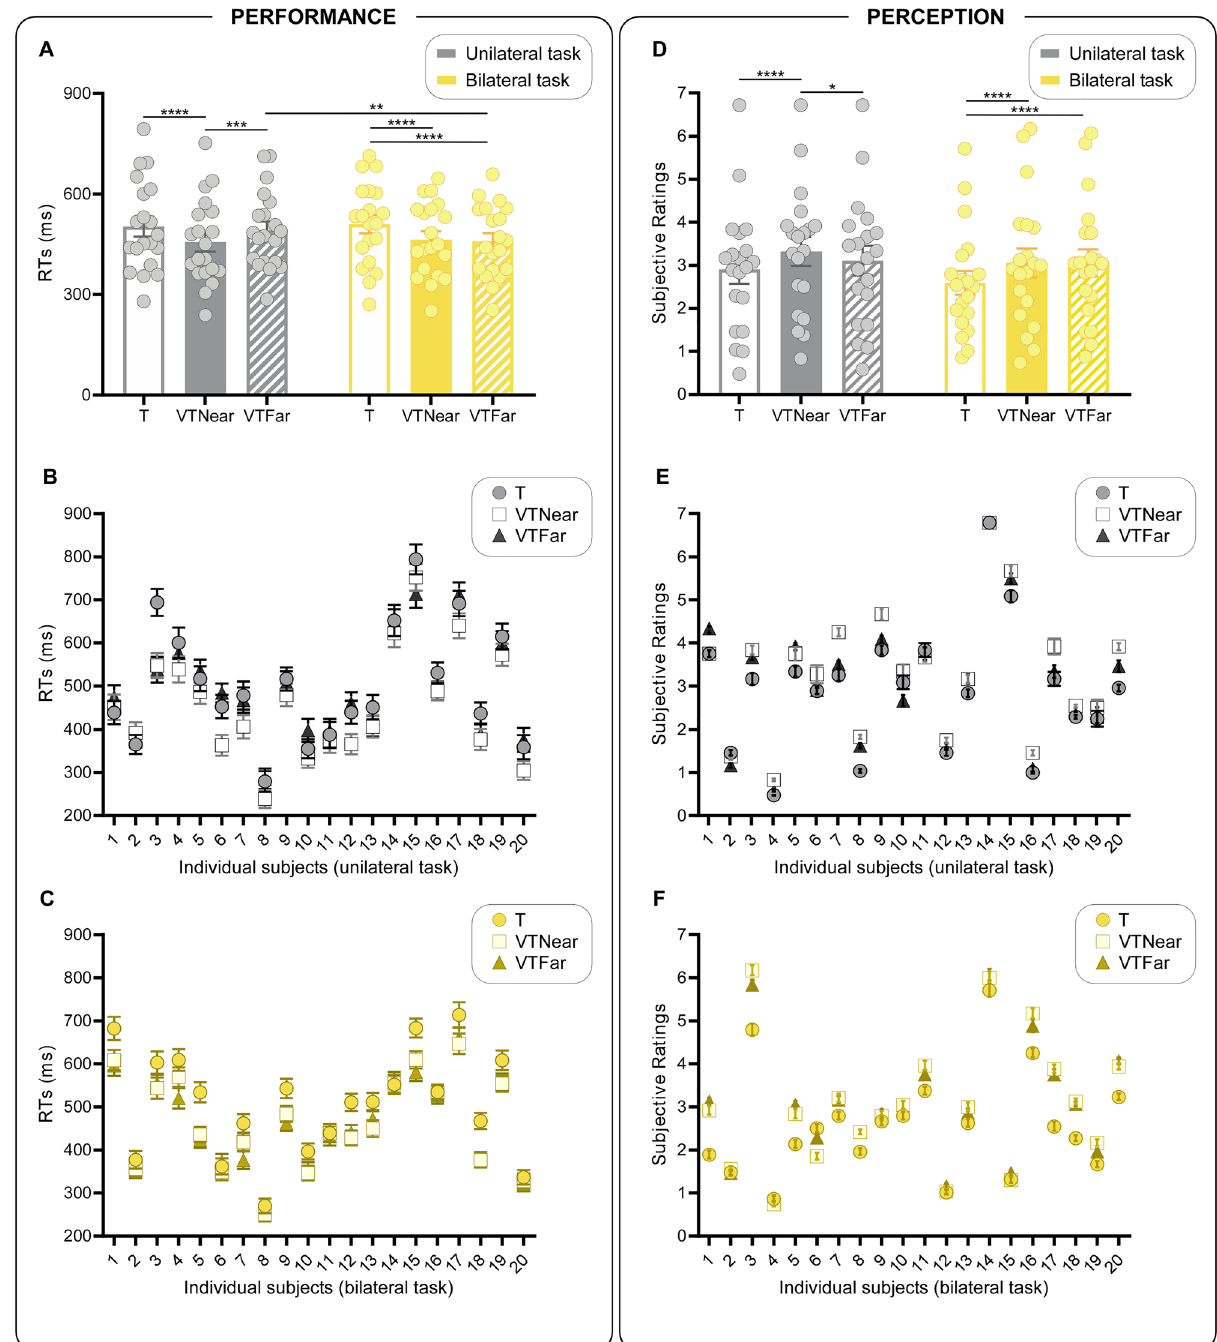
Figure 2. Performance and perception results. ( A,D) Represent the task × condition interactions. Bars represent the mean RTs ( A ) and the mean subjective ratings ( D ) in T (empty), VTNear (solid), and VTFar (striped) conditions in the unilateral (grey) and in the bilateral (yellow) task. Error bars indicate standard error of the mean (SEM). Dots represent individual participants. *p < 0.05; **p < 0.01; ***p < 0.001; ****p < 0.0001. ( B,C,E,F) Represent the mean RTs ( B,C ) and the mean subjective ratings ( E,F ) of each one of the 20 tested participants, in each condition, and separately for each task [unilateral: ( B,E ); bilateral: ( C,F )]. Dots represent mean individual values in the T condition, squares represent mean individual values in the VTNear condition and triangles represent mean individual values in the VTFar condition. Error bars indicate standard error of the mean (SEM). Note that, while in the unilateral task the majority of participants show faster RTs and higher ratings in the VTNear as compared to both VTFar and T, in the bilateral task they show significantly slower RTs and lower ratings in T as compared to both VTFar and